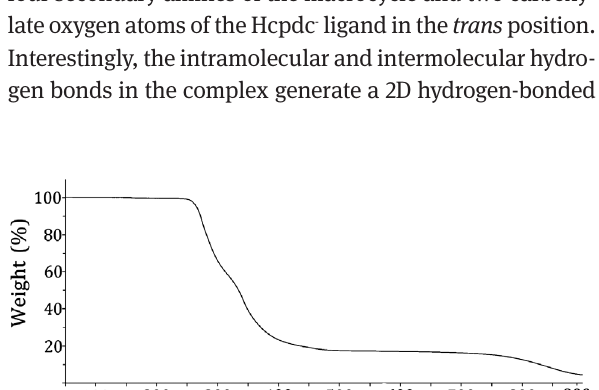
Figure 3 Thermogravimetric curve of [Zn(L)(Hcpdc)